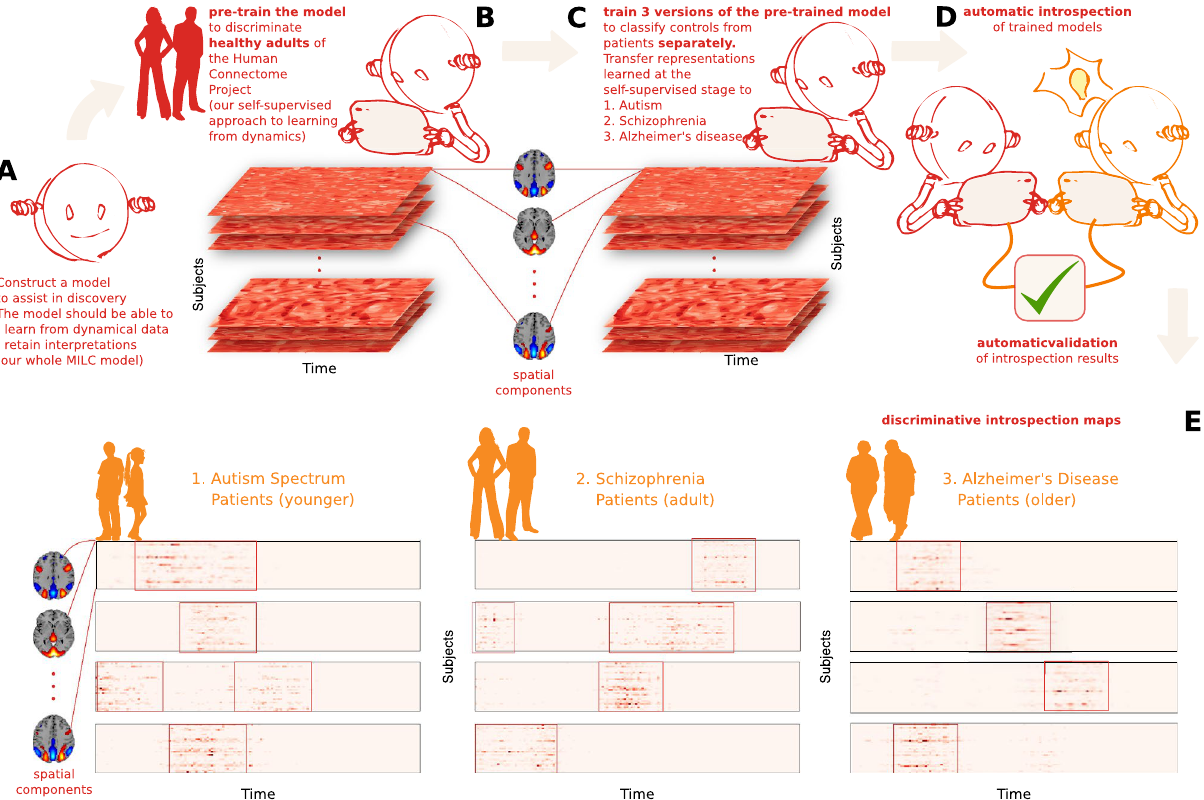
Figure 1. An overview of our approach to model interpretation (created in program Inkscape 1.1.2, http:// inksc ape. org/ relea se/ inksc ape-1. 1.2). ( A ) Construct a model for disorder-specific discovery: we divided the entire ICA time courses into multiple sliding windows. Then we fed them into the whole MILC model that learns directly from the disorder signal dynamics and retains interpretations for further introspection. ( B ) Leverage self-supervised pretraining to distinguish healthy subjects: learned representations assist the model in maintaining its predictive power when downstream training data is limited. ( C ) Construct a downstream model to discriminate patients from controls for each disorder starting with the pre-trained whole MILC weights: transfer of representations learned during pretraining simplifies convergence and balances overfitting. ( D ) Introspection of the trained downstream models: we compute saliency maps as a rationale used by the model behind every prediction using interpretability methods to extract meaningful, distinctive parts of the data. Subsequently, the estimated salient aspects of the dynamics go through an automatic validation process. To this end, we use the most salient features to retrain an independent SML model that confirms the salience of the features. This information can then be relayed to a human expert in the relevant field to interpret further and advance knowledge about the disorders. ( E ) Examples of saliency maps as deemed highly predictive by the models for their predictions in three different discriminative tasks. Please note that the red boxes mark the highly discriminative salient parts of the